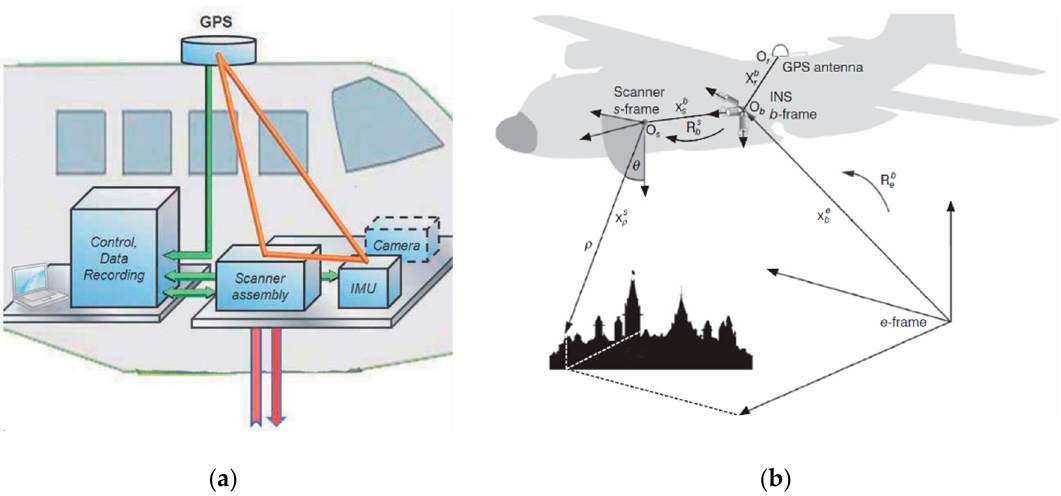
Figure 2. ( a ) Airborne LiDAR system in airplane [20] and ( b ) observation geometry of airborne laser scanning: s —sensor frame, defined by principle axes of laser scanner, b —body frame, realized by the triad of accelerometers in INS, e —earth-centered earth-fixed (ECEF) frame, realized by ITRF [18]. It should be noticed that the defined frames in the system are right-handed Cartesian systems.